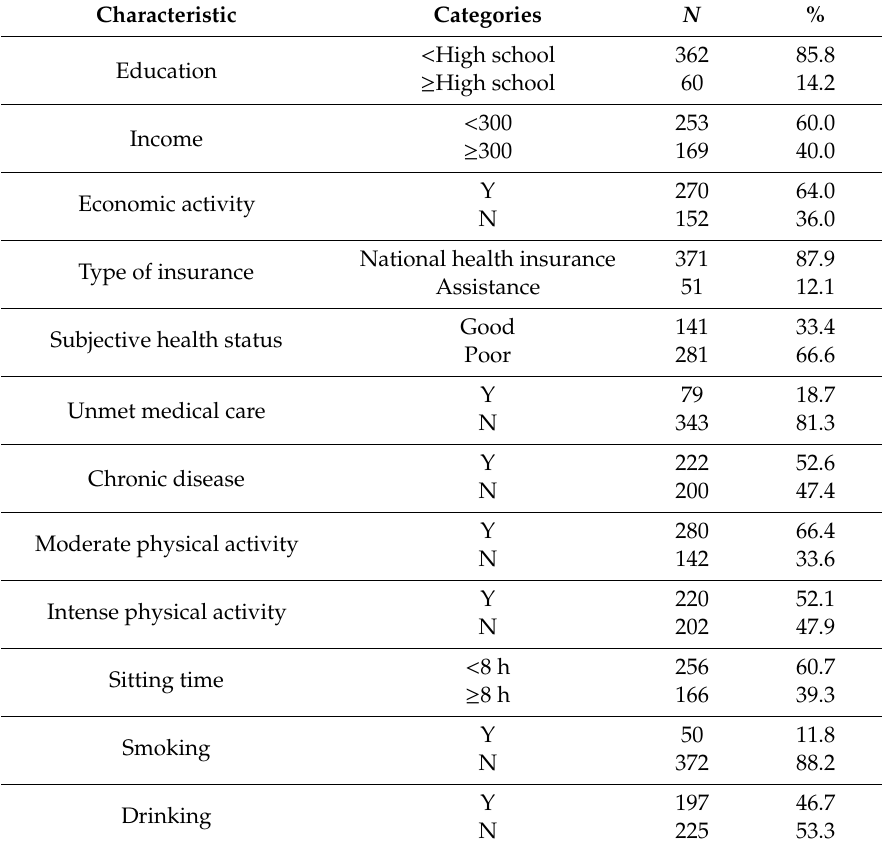
Table 1. General characteristics of research participants ( n =